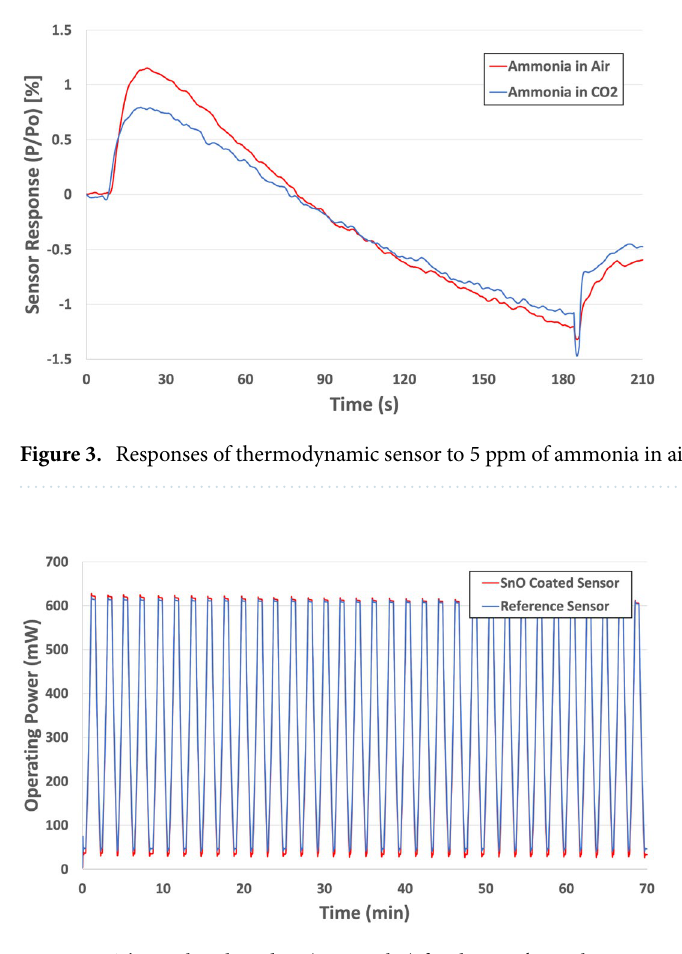
Figure 4. Thermal cycling data (~ 35 cycles) for the SnO 1+ catalyst sensor and the reference sensor in air (100% RH).